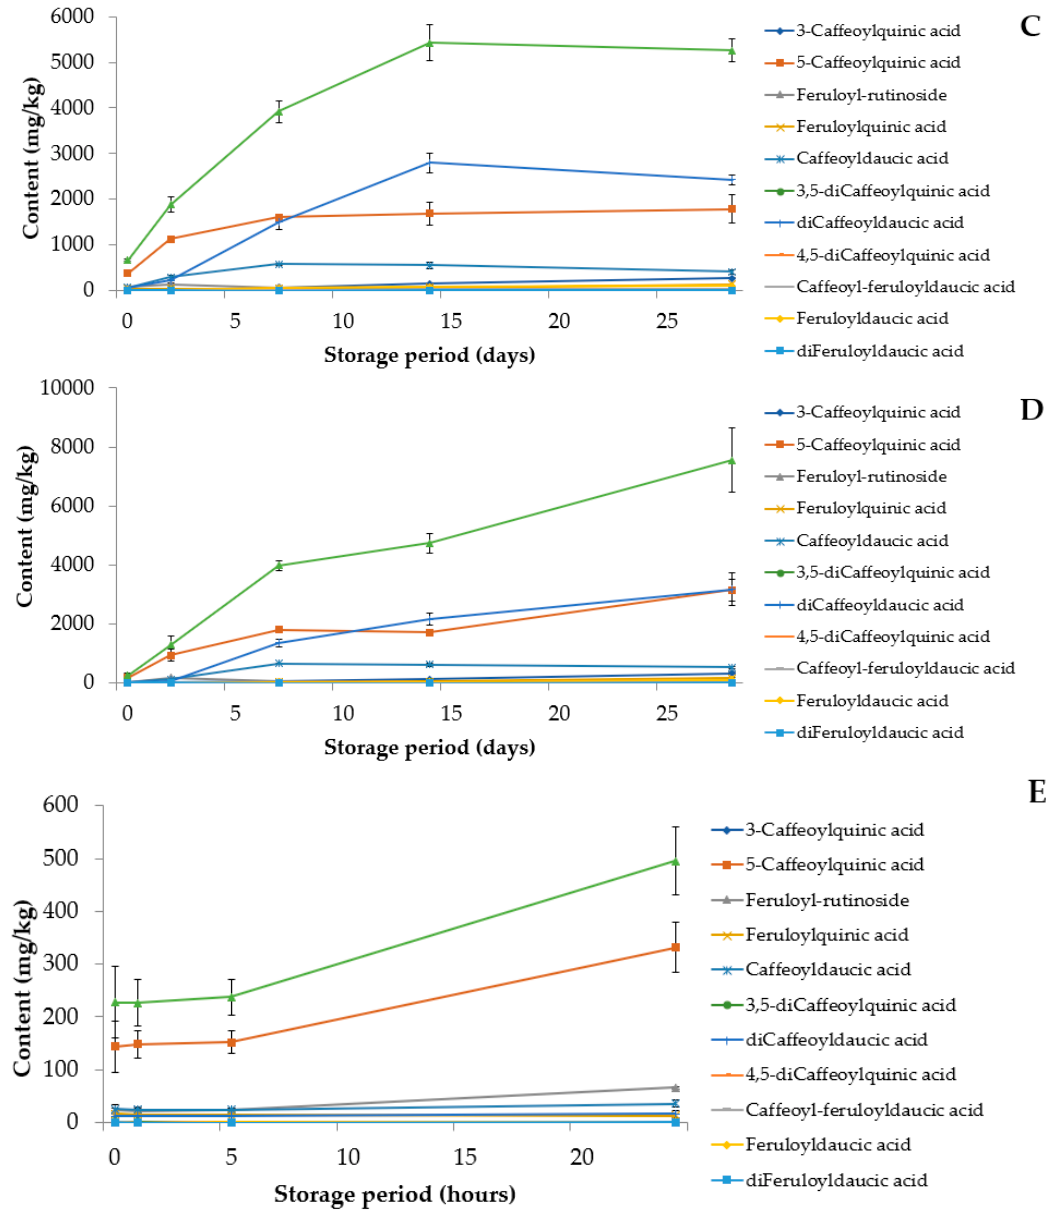
Figure 4. Phenolic acid composition (mg/kg DW) of untreated ( A ), washed ( B ), polished ( C ), peeled ( D ) and grated ( E ) carrots stored at 8 °C for either 28 days or 24 h.